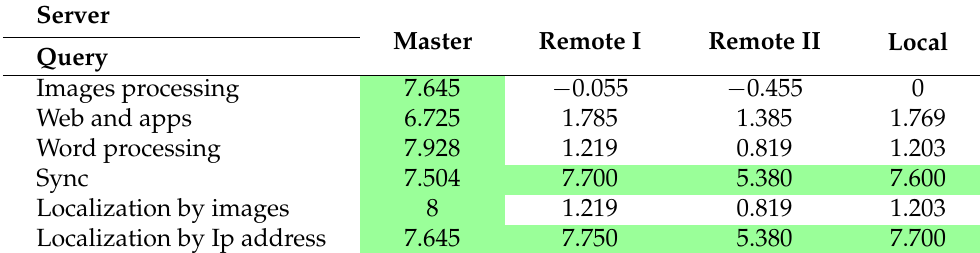
Table 17. saaq score values for scenarios O6 and O7.